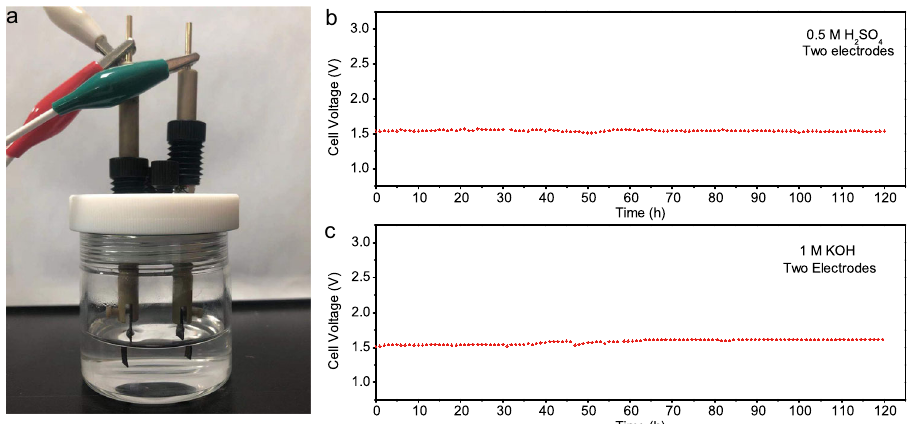
Fig. 4 | Overall water-splitting performance. a Digital photograph of the homemade two-electrode cell for water splitting. The corresponding chronopotentiometric curves at 10mAcm − 2 in b 0.5M H 2 SO 4 , and c 1M